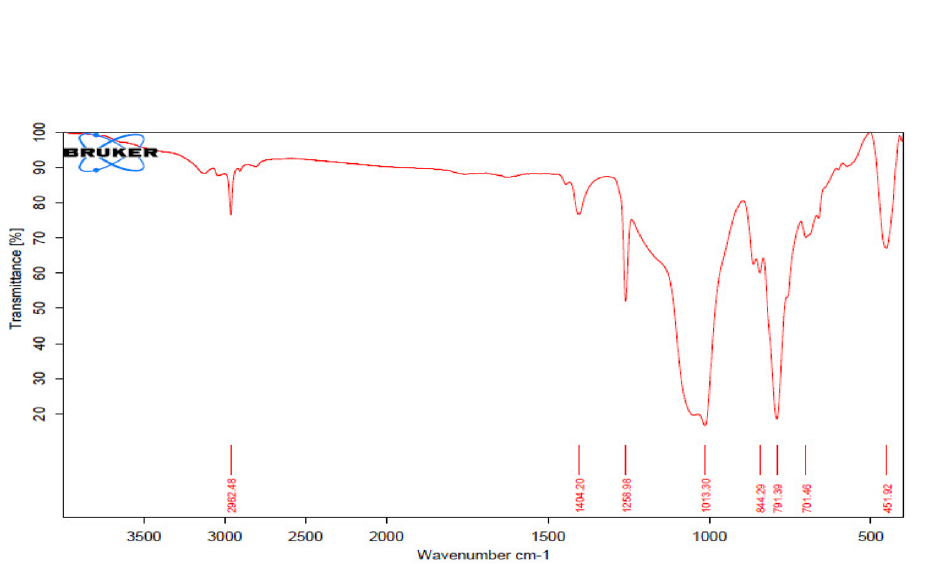
Figure 9. Fourier Transform Infrared Spectroscopy for PDMS/SiO 2